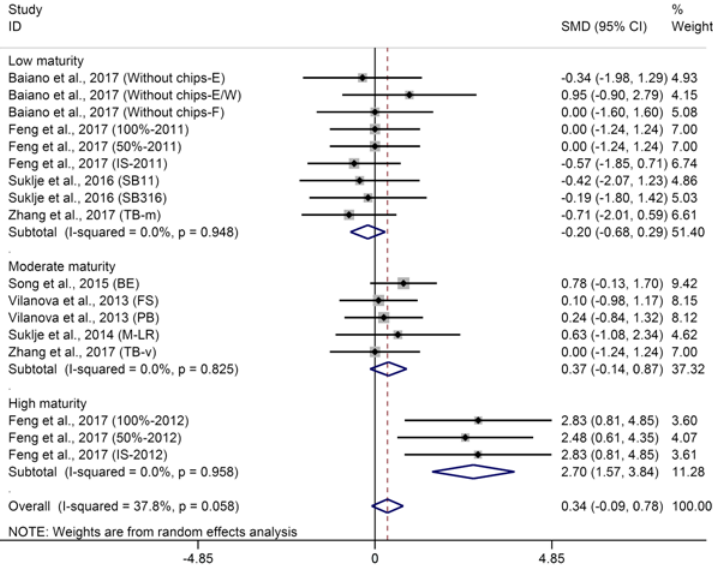
Figure 5. Meta-analysis for the effects of basal defoliation on β -phenylethanol in wine, of which trials were categorized based on the berry maturity level (low maturity of ◦ Brix < 23, moderate maturity of 23 < ◦ Brix < 25, high maturity of ◦ Brix > 25).